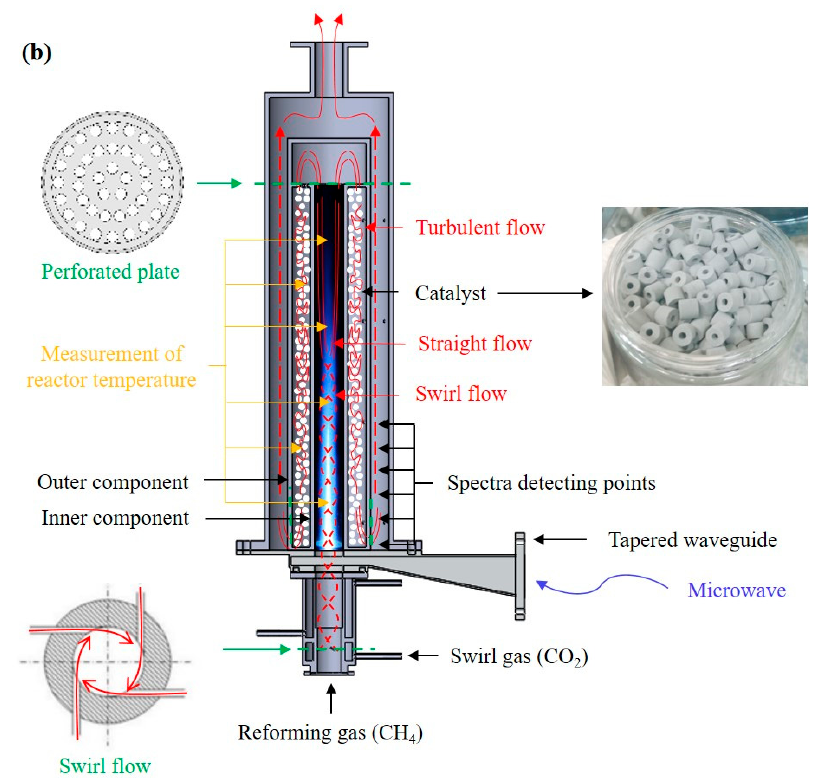
Figure 9. ( a ) Flow diagram and ( b ) schematic diagrams of the experimental setup of microwave plasma-catalytic reactor used for syngas production.